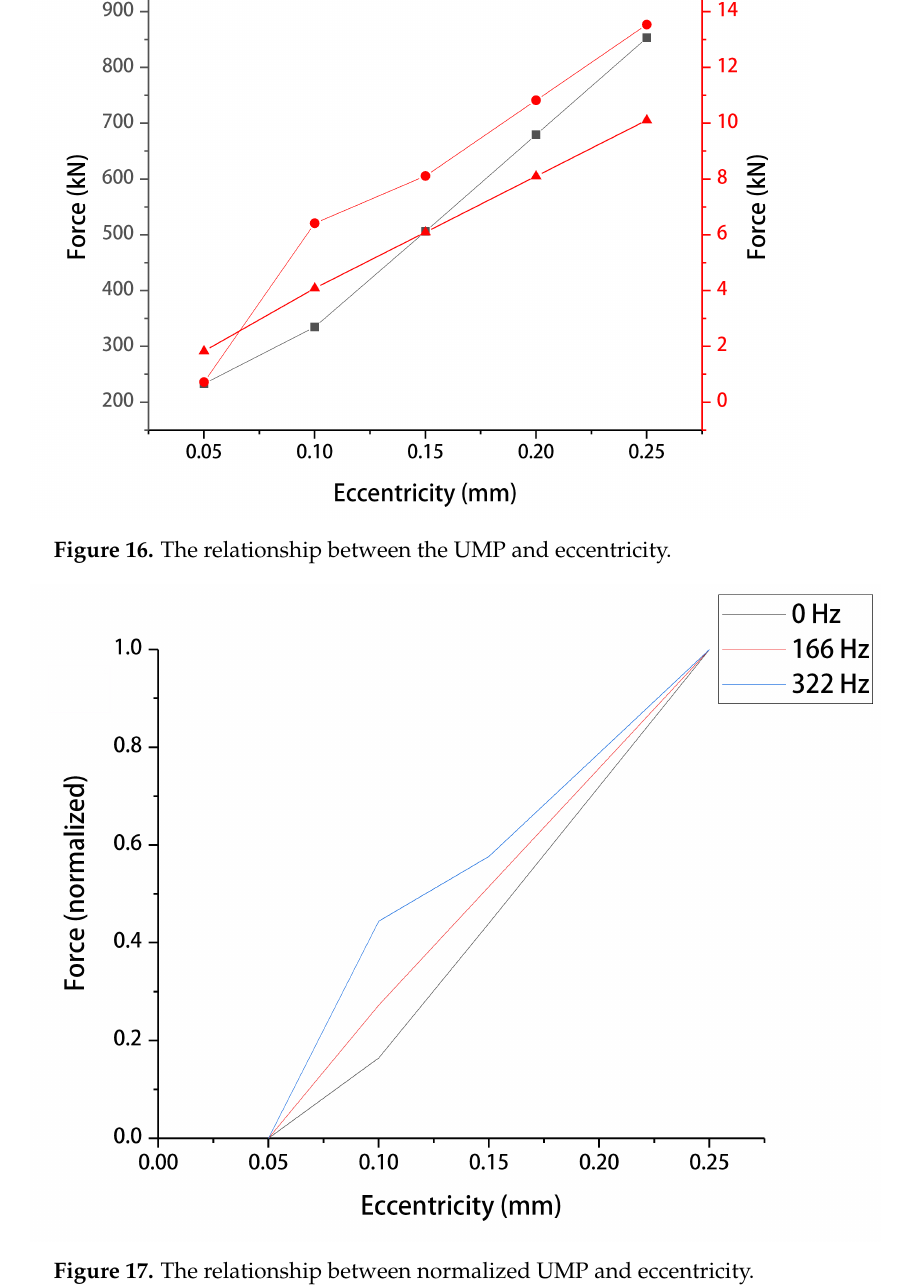
Figure 17. The relationship between normalized UMP and